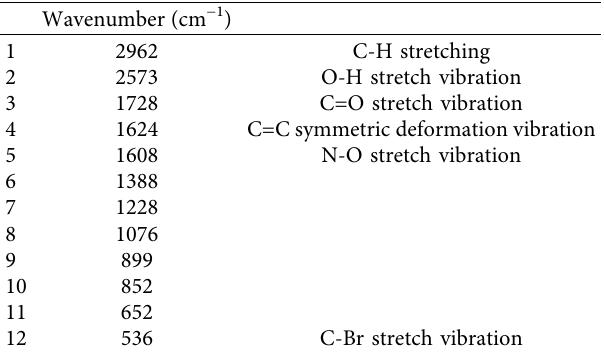
Figure 3: FTIR spectrum of tunichrome released from Phallusia nigra Persian Gulf marine Table 5: FTIR of tunichrome released from Phallusia nigra Persian Gulf marine tunicate.